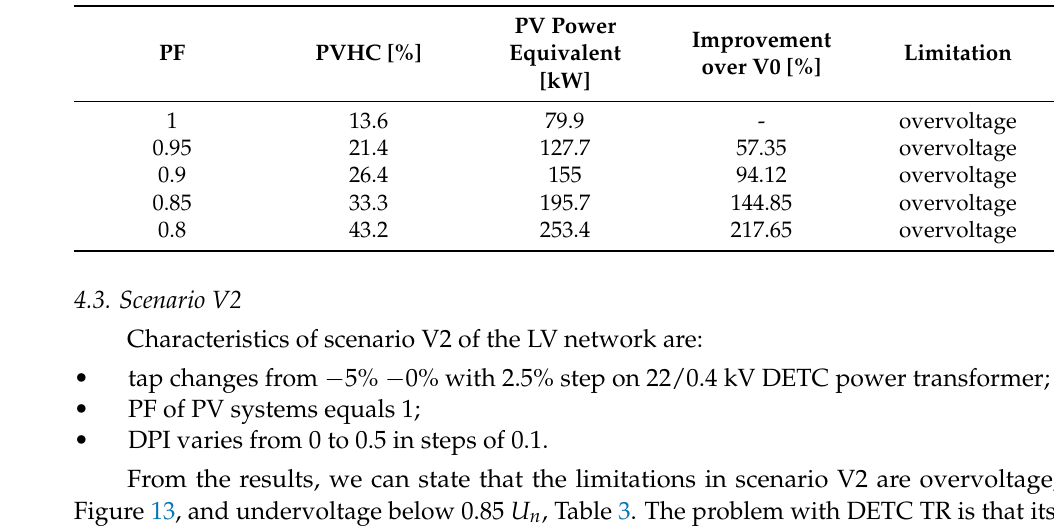
Figure 12. Total power losses for PV PF 0.95 ( left ) and 0.80 ( right ). Table 2. PVHC results for different reactive power absorbing PF of PV